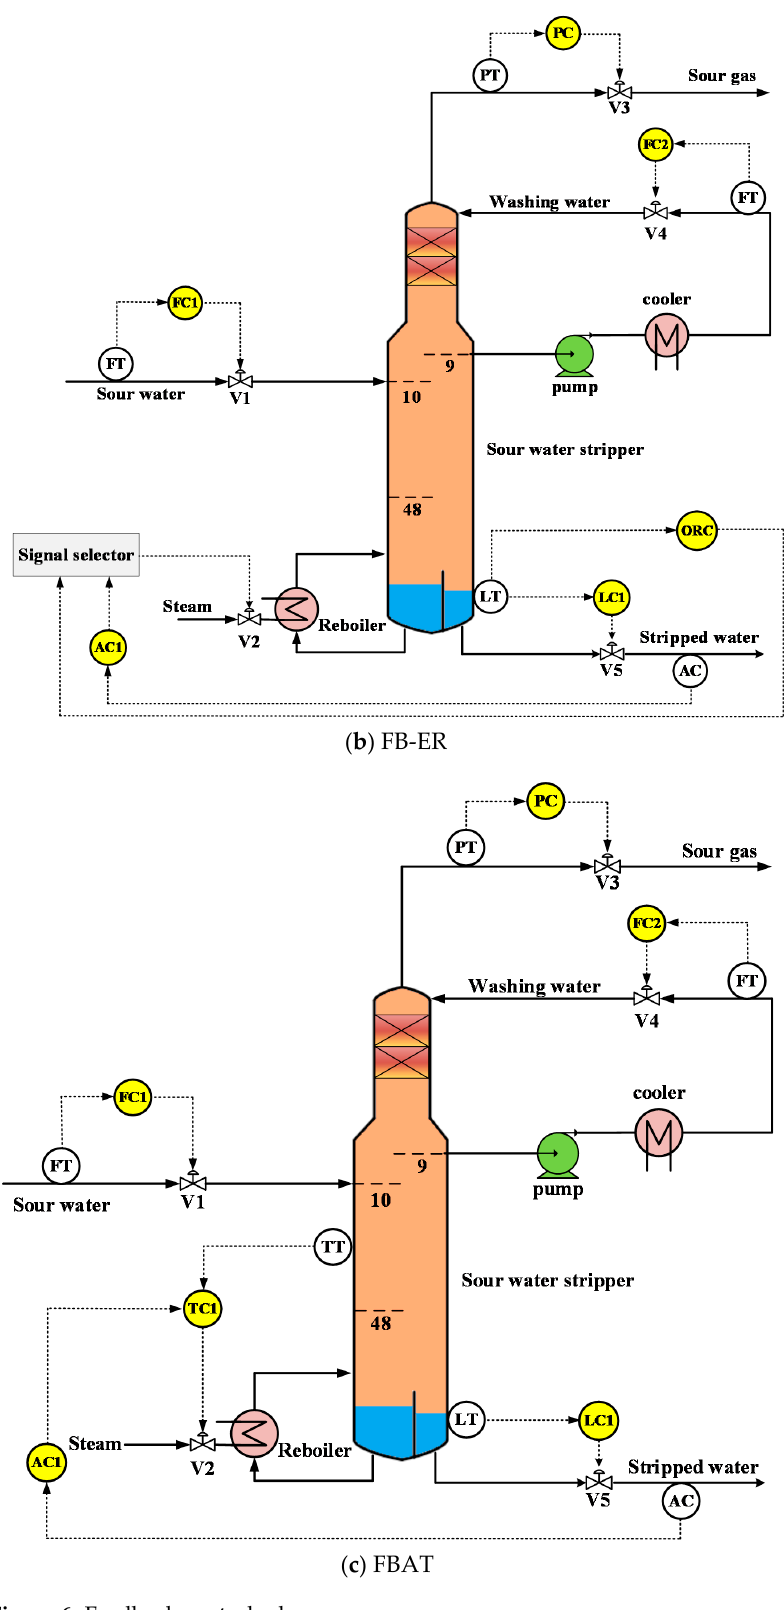
Figure 6. Feedback control schemes.